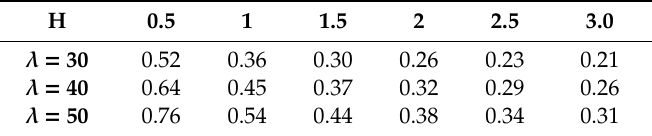
Table 1. Values of (turbulent Langmuir number) La t for di ff erent combinations of wavelengths ( λ , m) and wave heights ( H , m). H